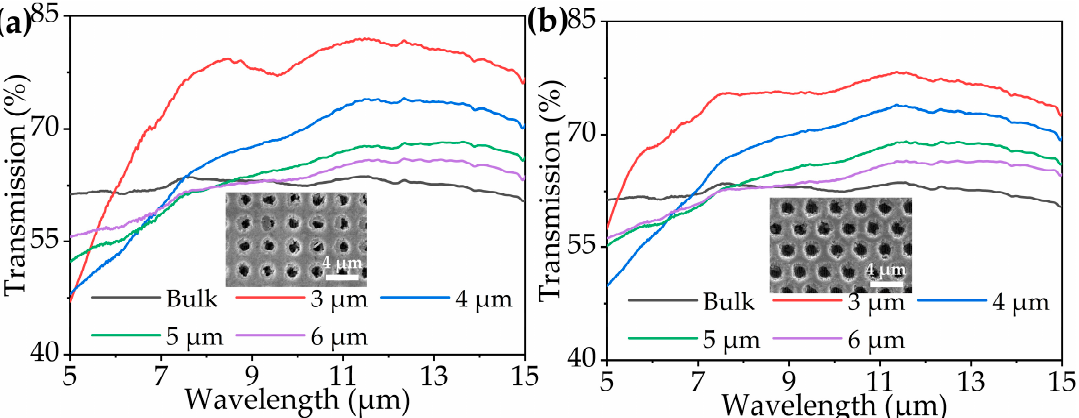
Figure 7. Transmission of the ( a ) tetragonal and ( b ) hexagonal arrangement ARMs with the period from 3 µm to 6 µm in the range of 5–15 µm (burst 3 mode; 500 nJ of single-pulse energy). The inset of the figure represents an SEM image of the arrangement of ARMs with a period of 4 µm.